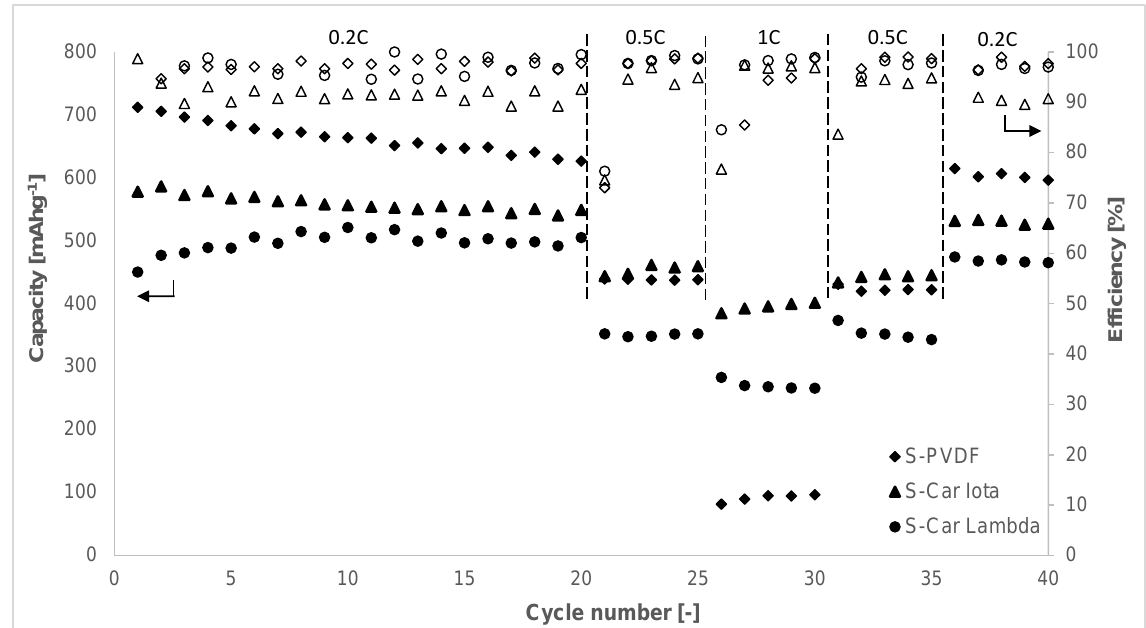
Figure 3. Galvanostatic cycling of the S-PVDF, S-Car-Iota, and S-Car-Lamb electrodes at different C-rates.